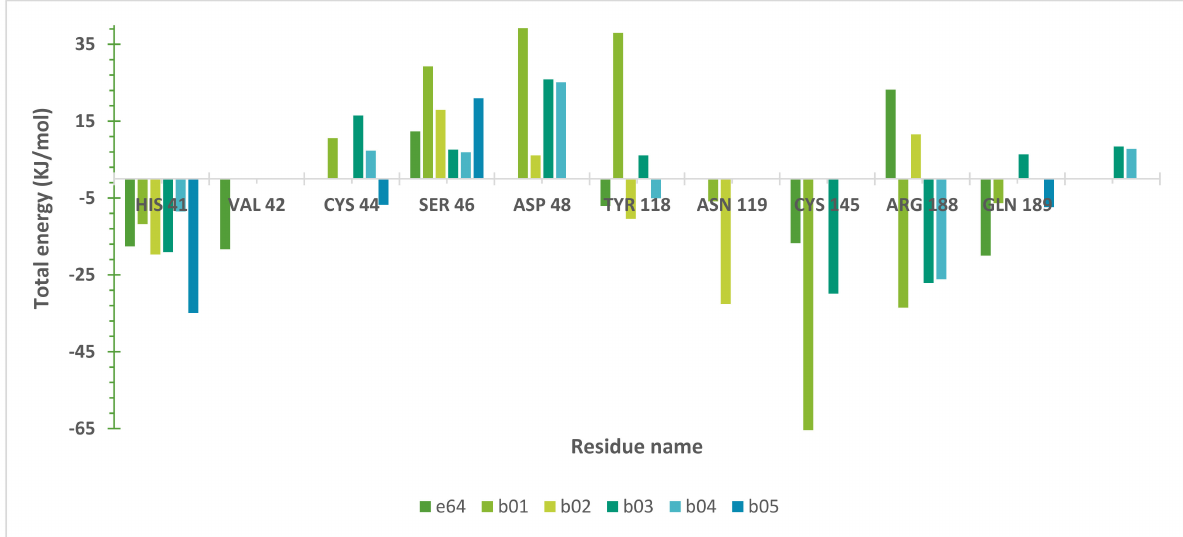
Figure 7. Residue contributions to the binding energy of SARS-CoV-2 Mpro complexes. The main residues with energy interactions ( ∆ Ebinding > ± 5 kJ/mol) are highlighted. For Mpro sub-site definitions, see the